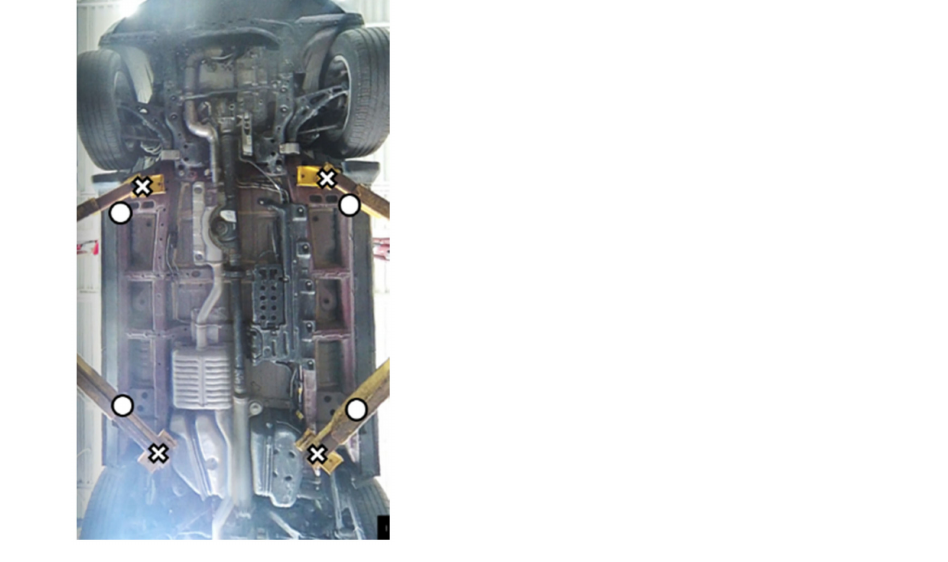
Figure 7. Difference between the lifting points used (crosses) and those recommended by the manufacturer (circles) due to the characteristics of the lift (arm